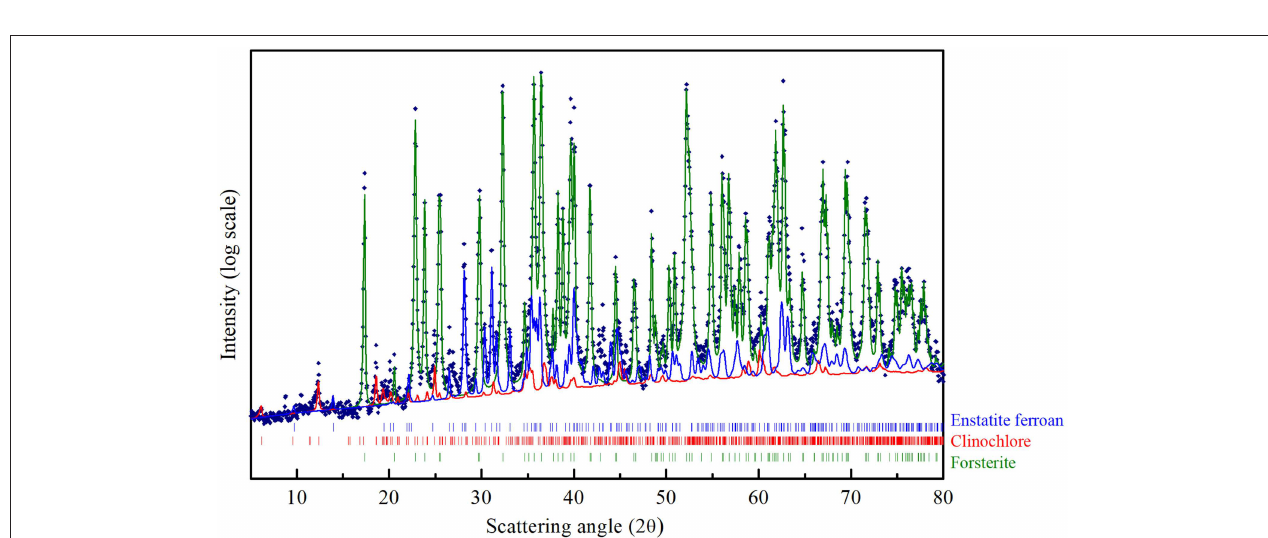
FIGURE 1 | CuK α XRD pattern of the Olivine in the as received state. The structural refinement procedure by Rietveld method, allowed to quantitatively evaluate the contribution of the three phases indicated in the Figure: Forsterite (green line), Enstatite ferroan (blue line), Clinochlore (red trace).